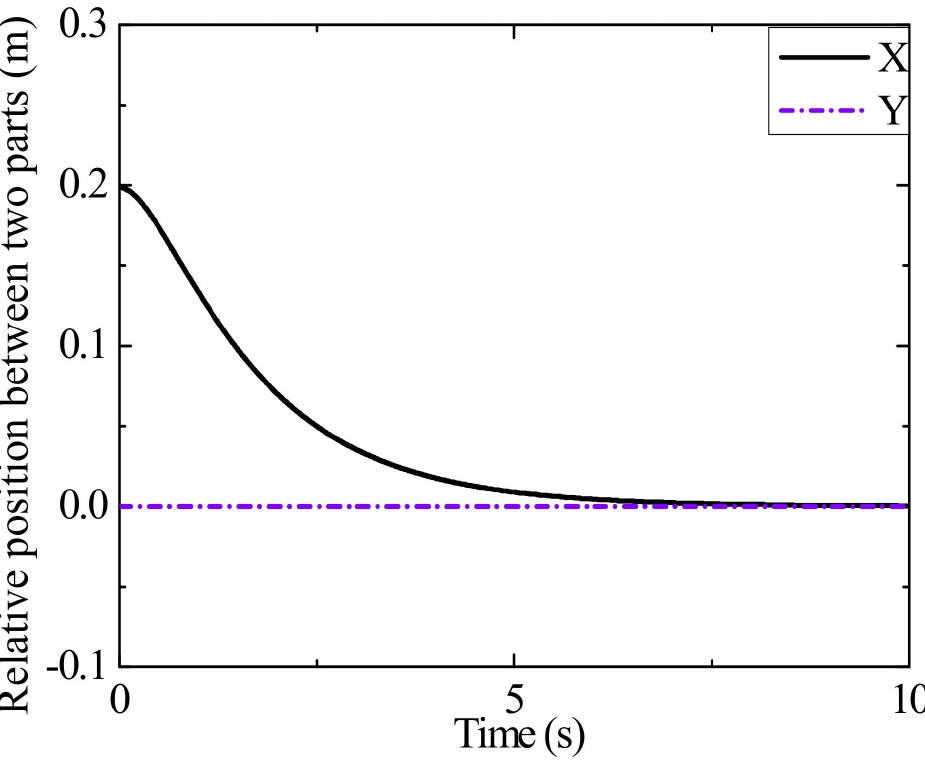
Figure 25. Relative position between the two modular components in the trajectory tracking